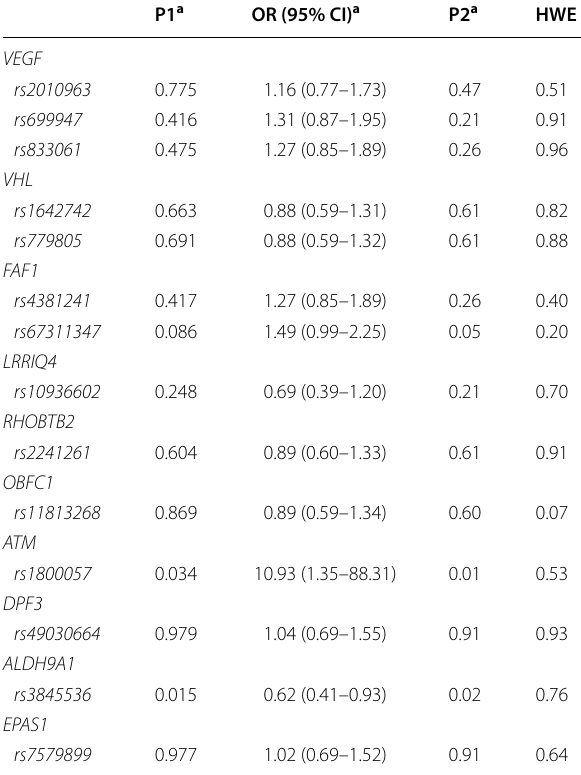
Table 2 Genotypic and allelic frequencies of 14 tag-SNPs in the RCC cases and